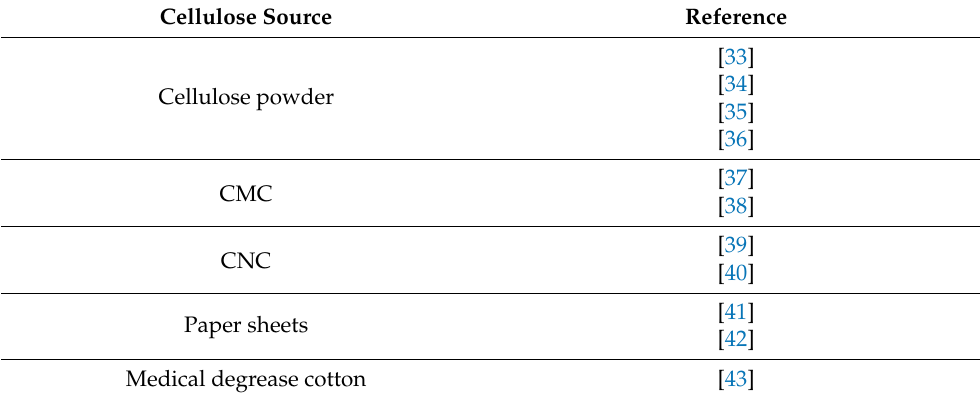
Table 1. Different types of cellulose used for the synthesis of cellulose–PEI